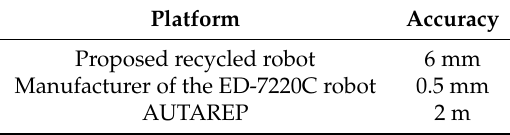
Table 6. Robot accuracy of experimental platforms based on the ED-7220C robot